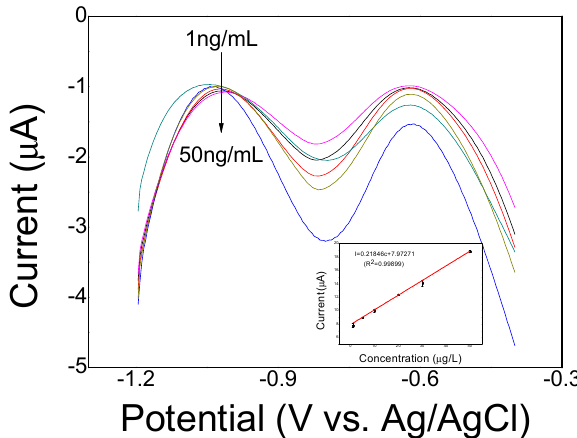
Figure 11. SWASV response curves at different concentrations. The inset shows the linear relationship between the current response and concentration from 1 ng/mL to 50 ng/mL. Table 1. Comparison of the prepared sensor with other reported modified electrode for Cd(II)